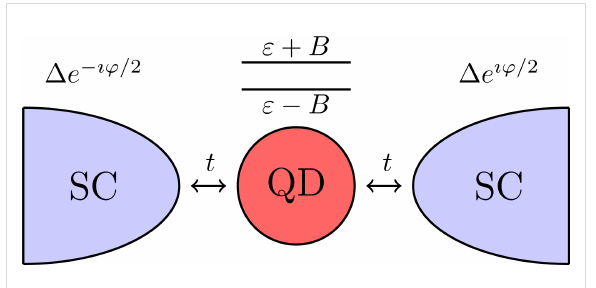
Figure 1: An SC–QD–SC Josephson junction realized by a two-level quantum dot in a magnetic field B and electric gate ε coupled with two superconducting leads. The two energy levels are respectively ε ± B . The dot is coupled to the superconducting leads via tunneling junc- tions with transparency t . The Josephson current I φ through the dot depends on the gauge-invariant phase difference φ between the two superconducting